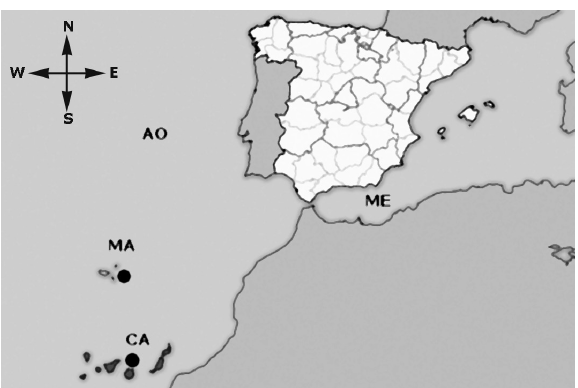
F ig . 1. – Map of the central North Atlantic (AO) showing sampling locations (black circles) at the Madeira Islands (MA) and Canary Islands (CA). (ME) Mediterranean